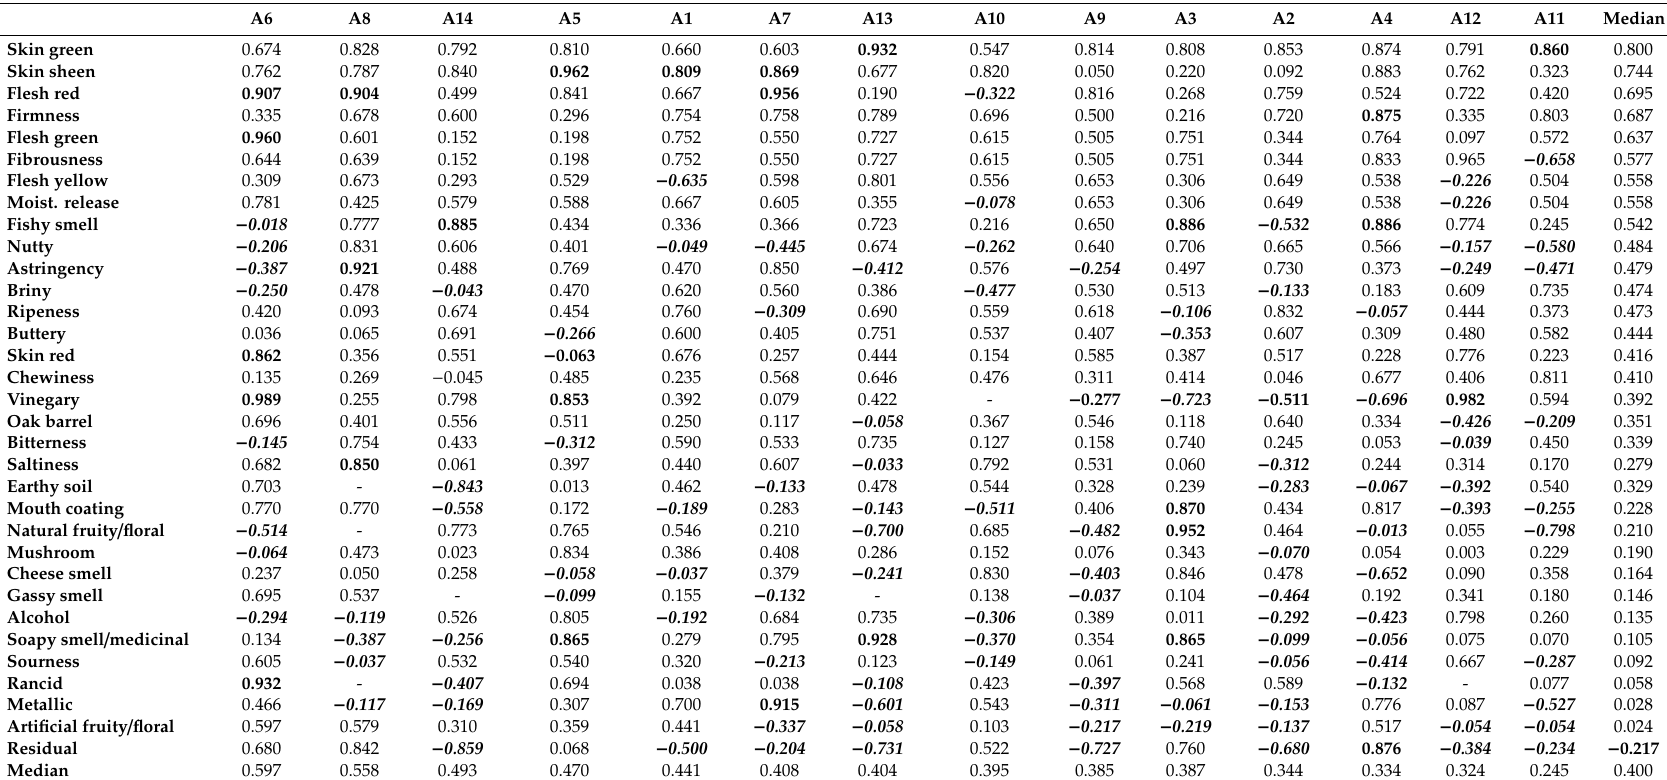
Table 4. Panelist agreement with panel as assessed by the correlation coe ffi